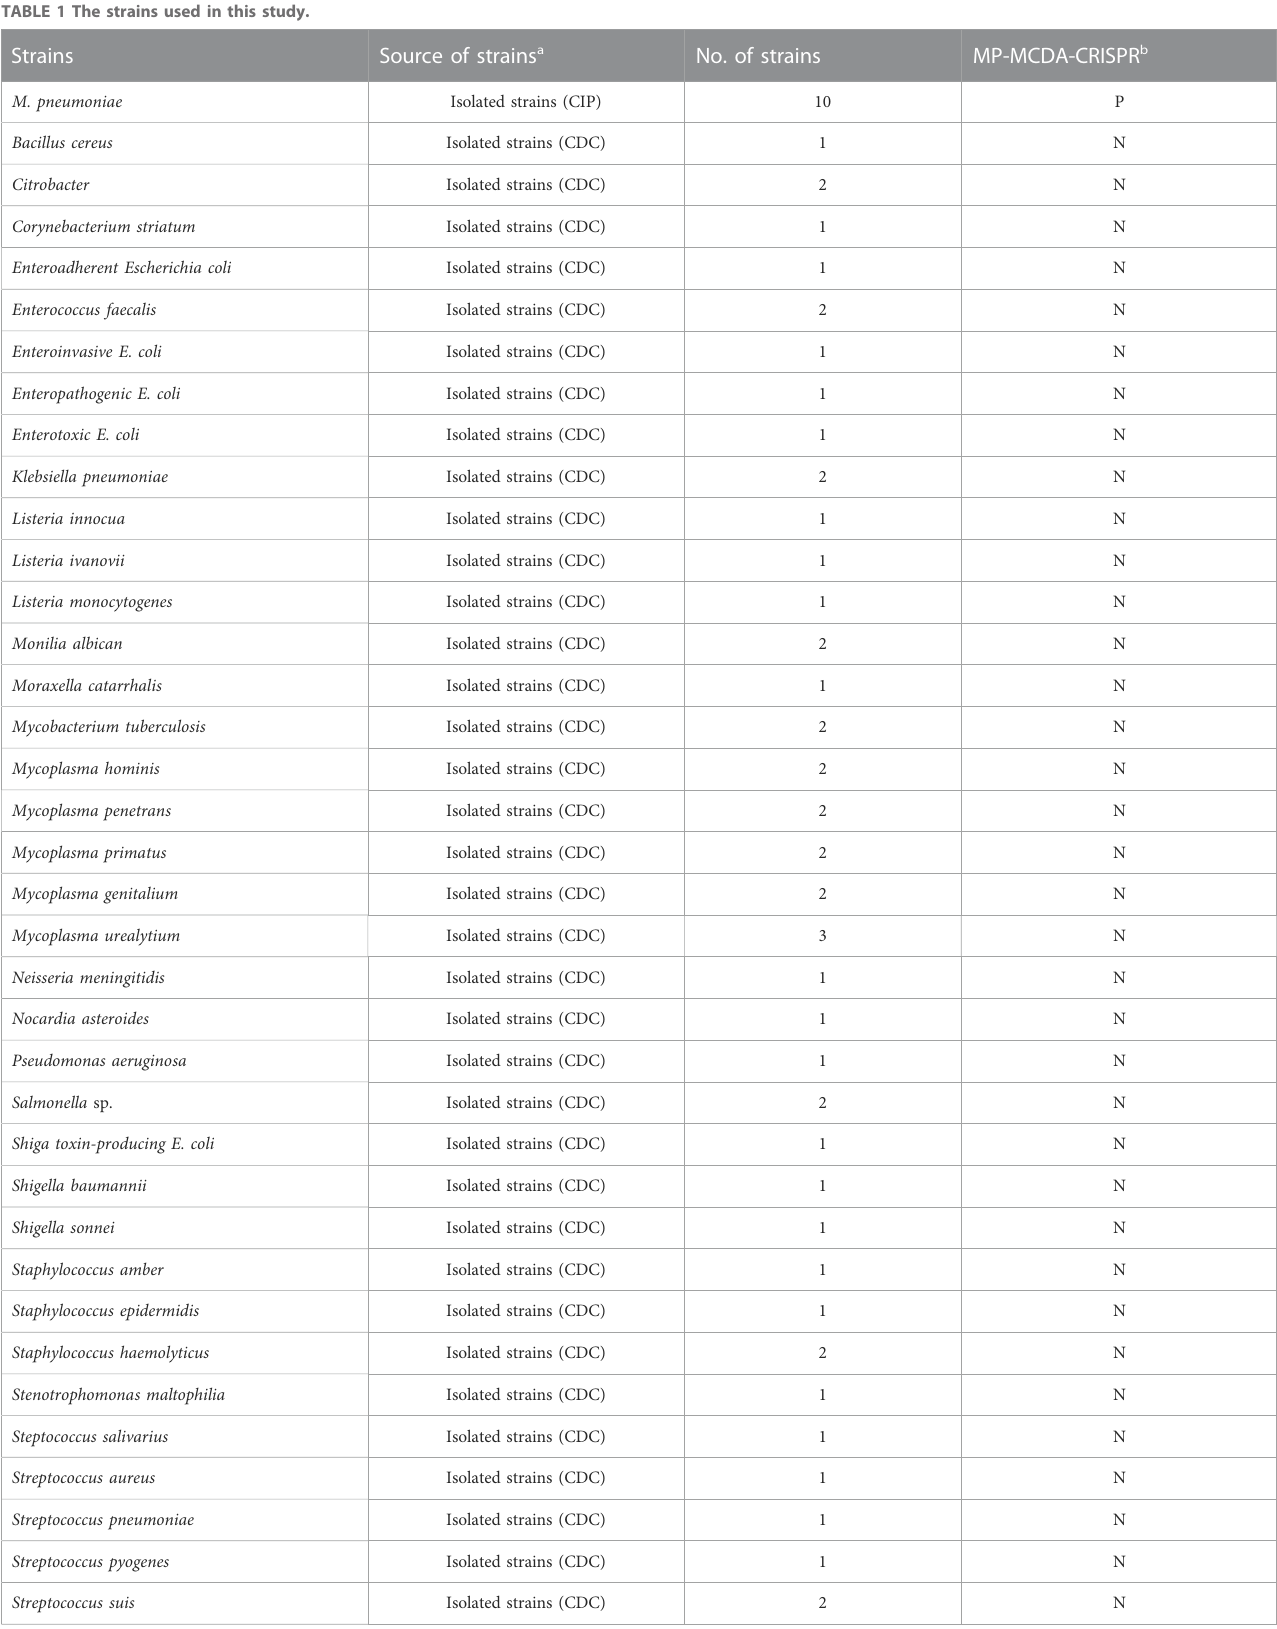
TABLE 1 The strains used in this study.